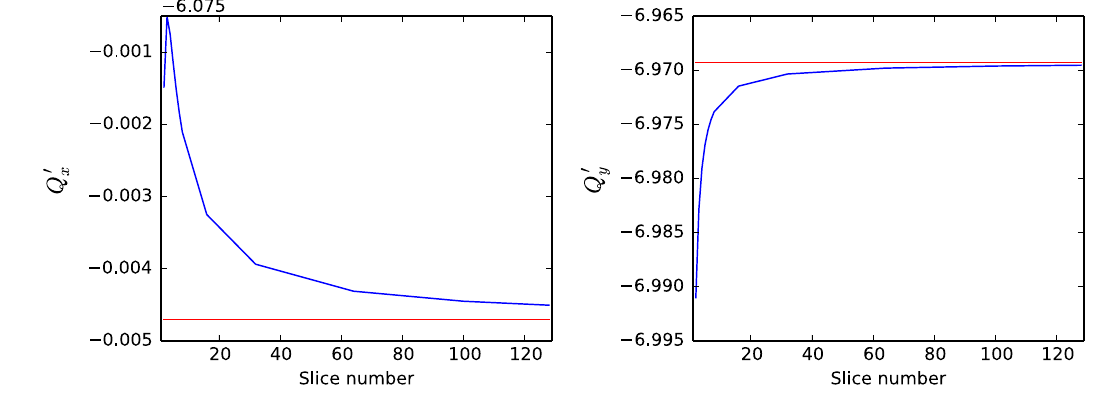
FIG. 3. Convergence behavior of the horizontal- and vertical chromaticities in the PS against the PTC results (red).